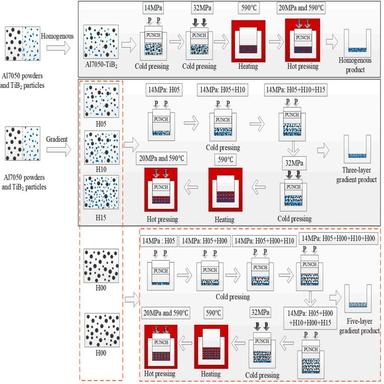
A schematic illustration of the VHS process for TiB2/Al7050 composites (HC, TFGM, and FFGM).